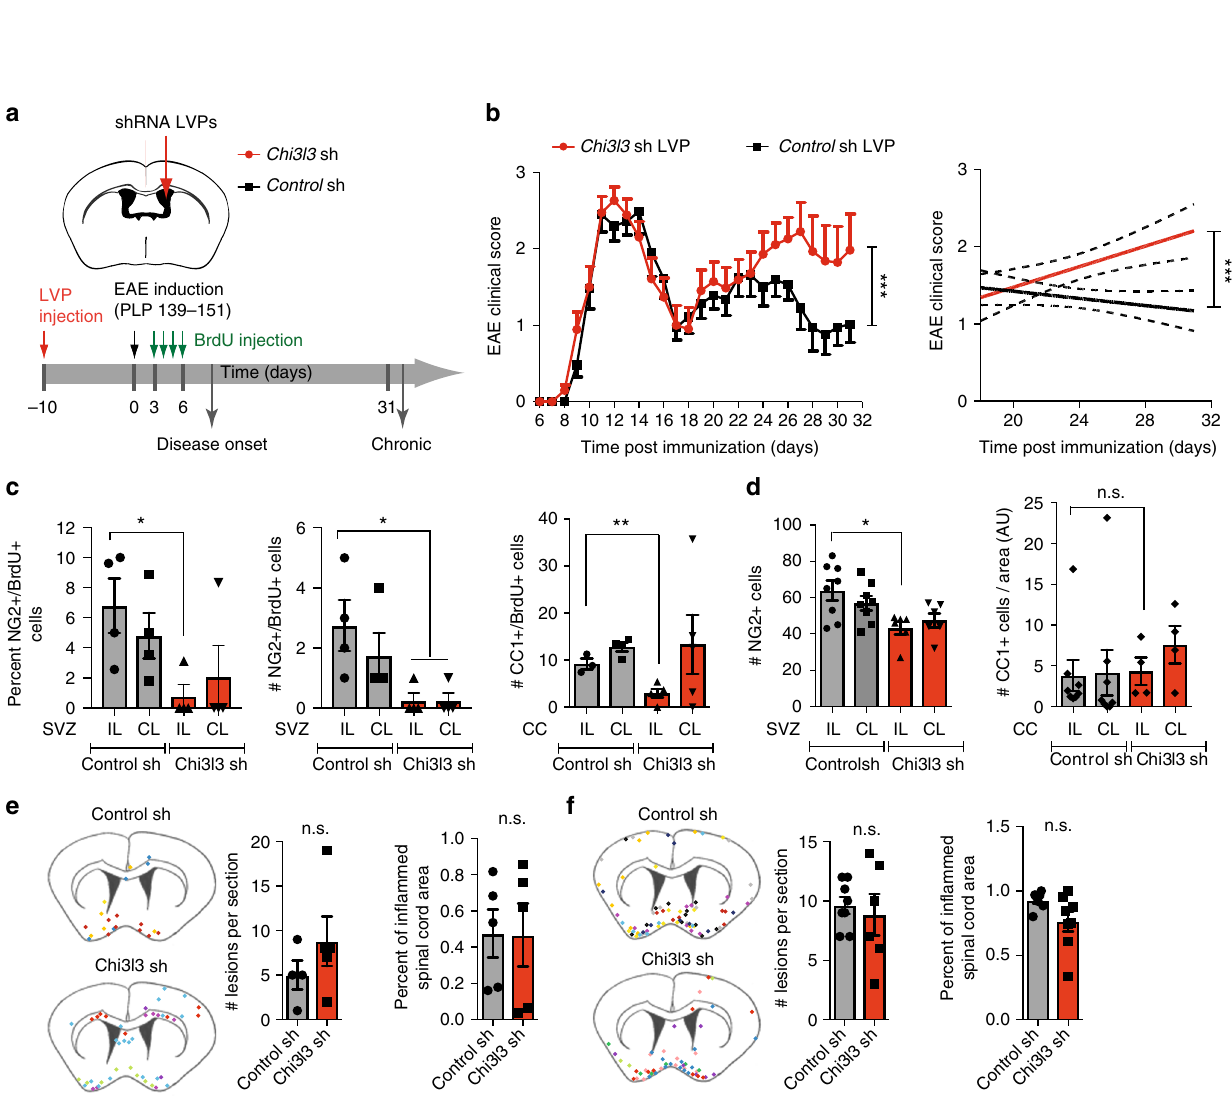
Fig. 5 Chi3l3 infusion induces pro-oligodendrogenic fate of subventricular zone neural stem cells in vivo. a Protocol of BrdU labeling via intraperitoneal (i.p.) injection and Chi3l3 administration. b – f Representative confocal images b , d and quanti fi cation c , e , f of the ipsilateral (IL) or contralateral (CL) subventricular zone (SVZ) of naive mice infused with Chi3l3 or PBS (vehicle) and immunostained for BrdU (green) and NG2 ( b , oligodendrocyte precursor cells, red) or Dcx ( d , neuroblasts, red). IL SVZ of Chi3l3-treated mice were compared with IL SVZ of vehicle-treated mice as well as the CL site of the same mouse. Dashed lines mark the ventricular wall of the right or left lateral ventricle (RLV; LLV). Scale bar (left), 50 μ m. Double-positive cells are indicated by yellow and white arrowheads and representative cells (box) are shown as high magni fi cation images (right). Scale bar (right), 5 μ m. Quanti fi cations show a signi fi cantly higher percentage of BrdU/NG2 double-positive cells c and reduced percentage of BrdU + /Dcx + cells e in the ipsilateral SVZ of Chi3l3 infused mice indicating pro-oligodendrogenic modulation of SVZ stem cell fate choice in vivo. f Quanti fi cation of the total number of BrdU labeled cells/mm 2 in the SVZ showed no signi fi cant difference between Chi3l3 or vehicle infusion in the ipsilateral or contralateral SVZ. (One-way ANOVA with Turkey ’ s post hoc test; c n = 2 mice (Control IL, CL), n = 4 (Chi3l3 IL), and n = 3 (chi3l3 CL); e n = 2 mice per group, n = 4 mice per group; mean ± s.e.m. * p < 0.05; ** p < 0.01; *** p <